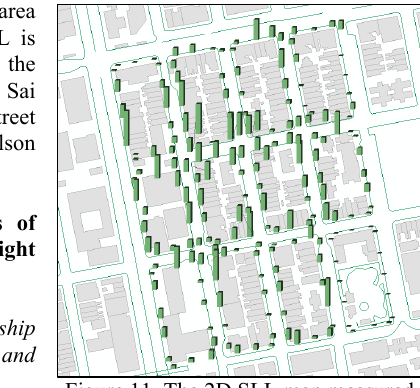
Figure 11. The 2D SLL map measured in western Mong